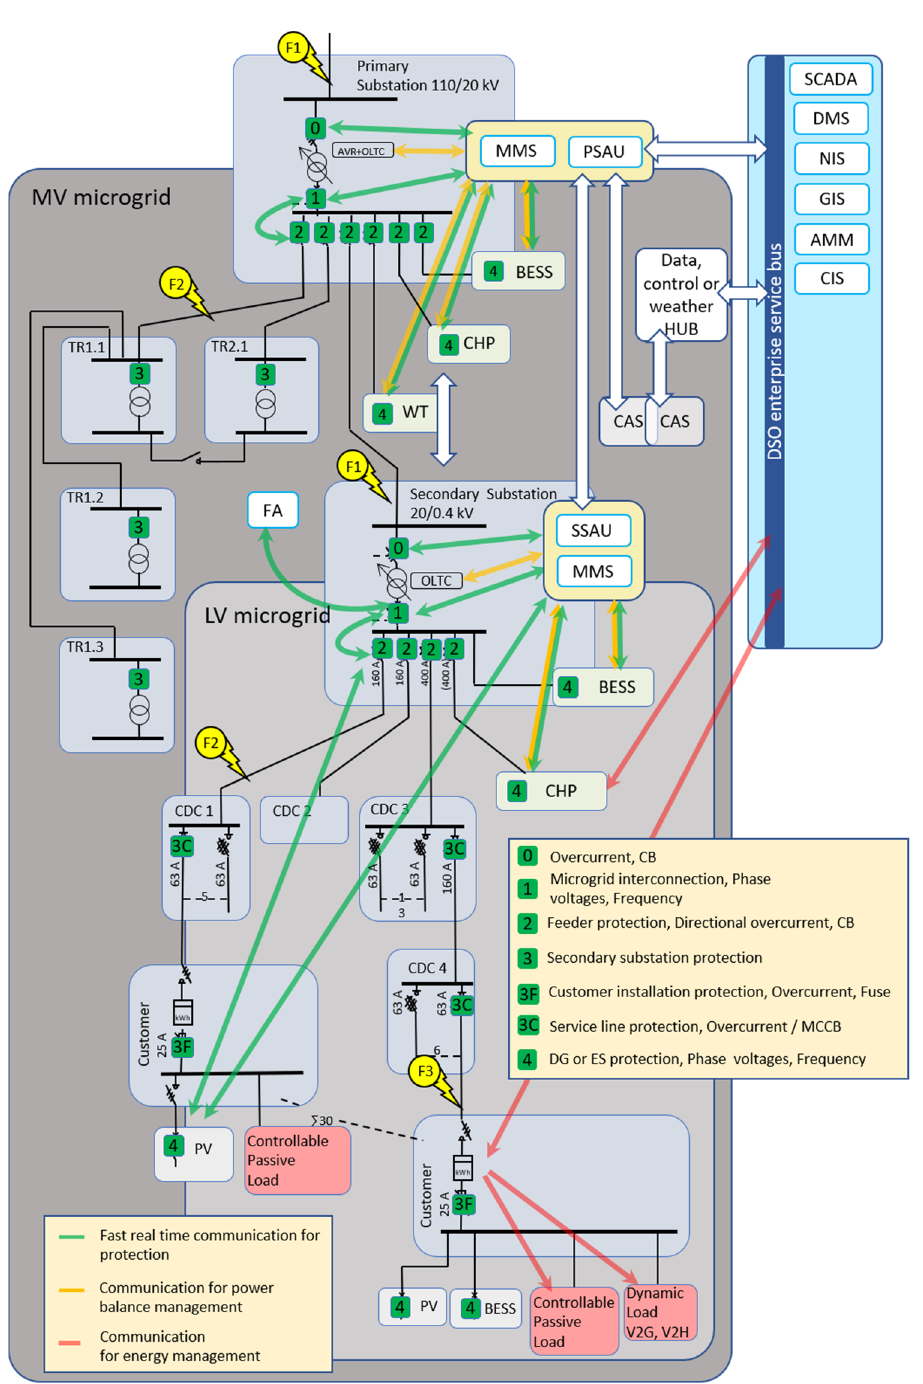
Figure 5. The suburban distribution network in the microgrid phase. Adapted from [13].